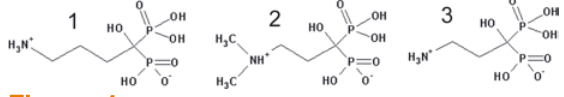
Figure 1. Zwitterionic structures of alendronic (1), olpadronic (2) and pamidronic (3) acids